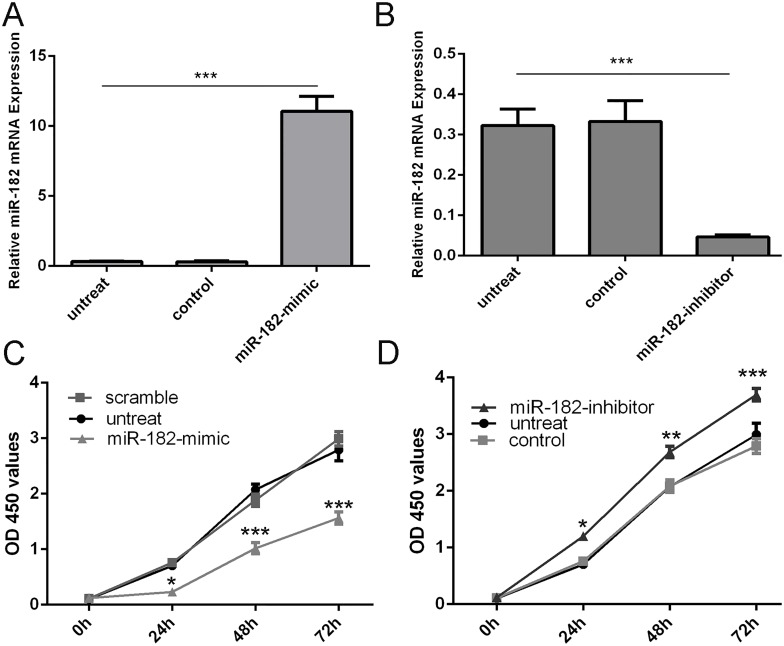
Overexpression of miR-182 inhibited tumor growth.(A) The miR-182 expression level of the indicated cells was measured by qRT-PCR. The expression of miR-182 was normalized to U6 snRNA. (B) The expression level of miR-182 in the indicated cells was measured by qRT-PCR. The expression of miR-182 was normalized to U6 snRNA. (C) Cell proliferation of the indicated cells was analyzed using CCK-8 assay. (D) Inhibition of miR-182 promote the osteosarcoma cell proliferation. *p<0.05, ** p<0.01, and ***p<0.001.